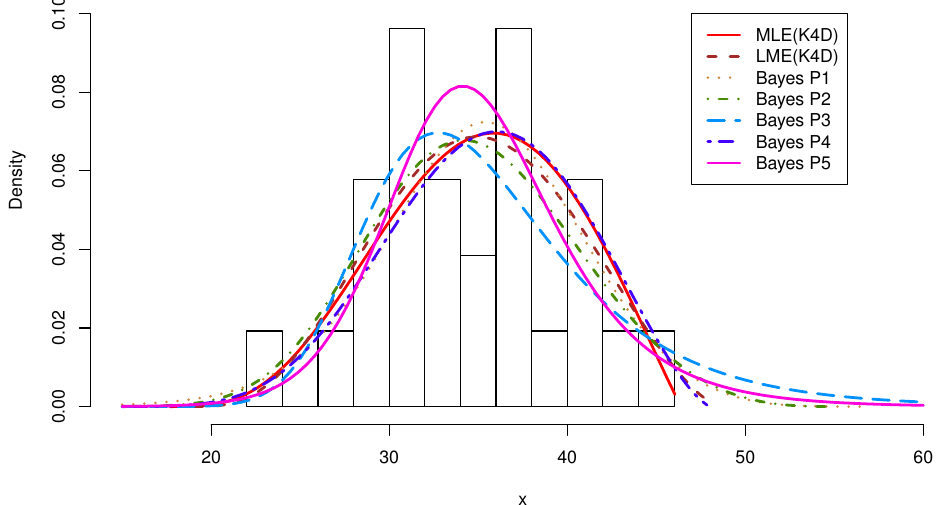
Figure 7. Probability density plots of four-parameter kappa distribution fitted to the annual maximum wind speeds at Udon Thani, Thailand, by various estimation